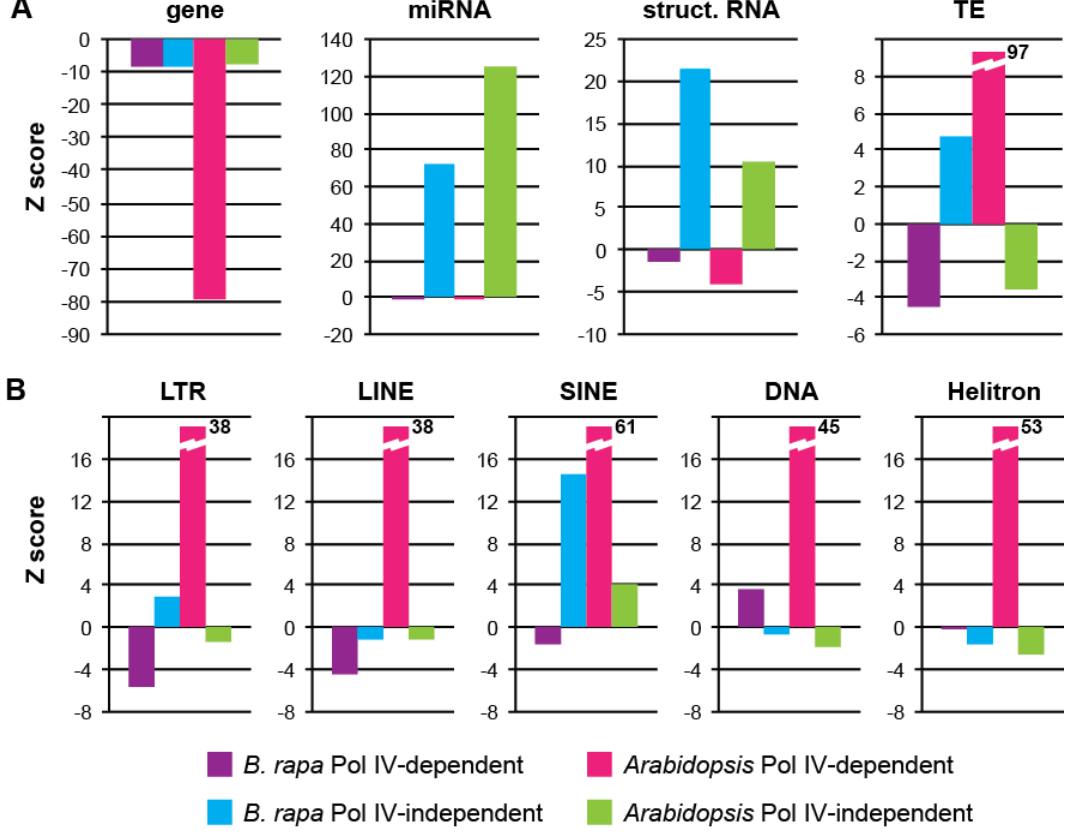
Figure 7. Genomic features at sRNA-generating windows . Over- and under-representation of annotation classes for Pol IV-dependent windows (0 (cid:177) 25% class) and Pol